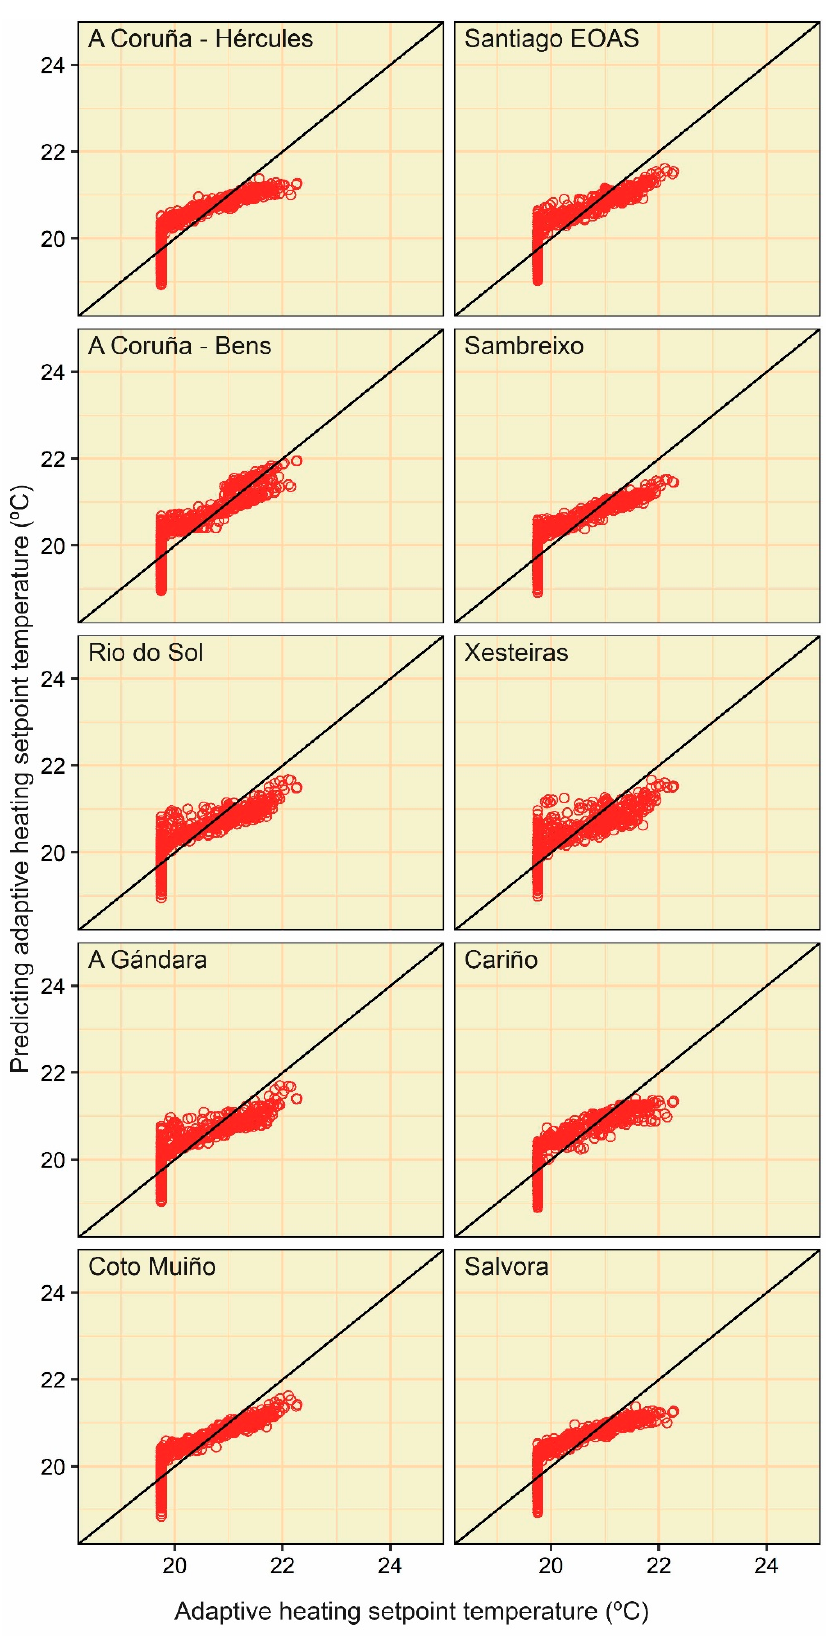
Figure A21. Point clouds between the actual and predicting adaptive heating setpoint temperature values (category III) of the MLR (approach 2).